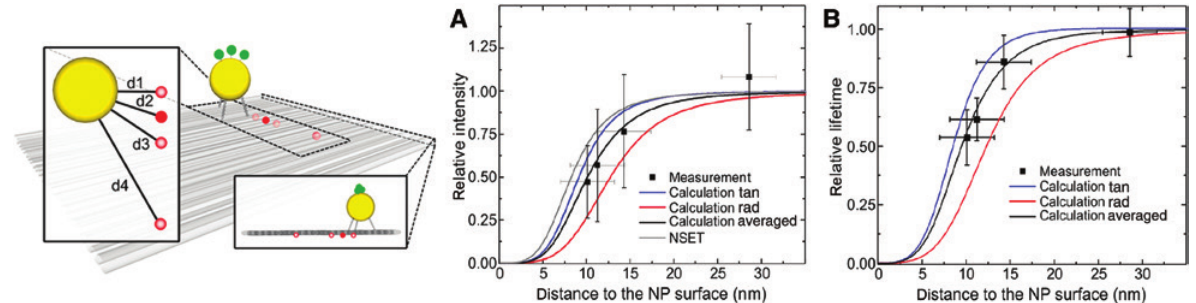
Figure 18: Left: Sketch of the two-dimensional DNA origami with attached metallic nanoparticle. To illustrate the dye positions, all four positions are shown simultaneously (d1d4), although every DNA origami sample contains only one red fluorophore. The green dots represent single-stranded DNA labeled with Cy3 to visualize the gold nanoparticles Right: (A) Relative change in fluorescence intensity and (B) fluores- cence lifetime as a function of the distance between the fluorophore and the MNP. The black squares represent the mean values and standard deviations obtained from the single molecule data. Blue, red, black, and gray solid lines represent the tangential, radial, weighted average, = 8.38 nm), respectively. Adapted with permission from Ref. [43]. Copyright (2015) American Chemical Society. and NSET calculation (with d 0